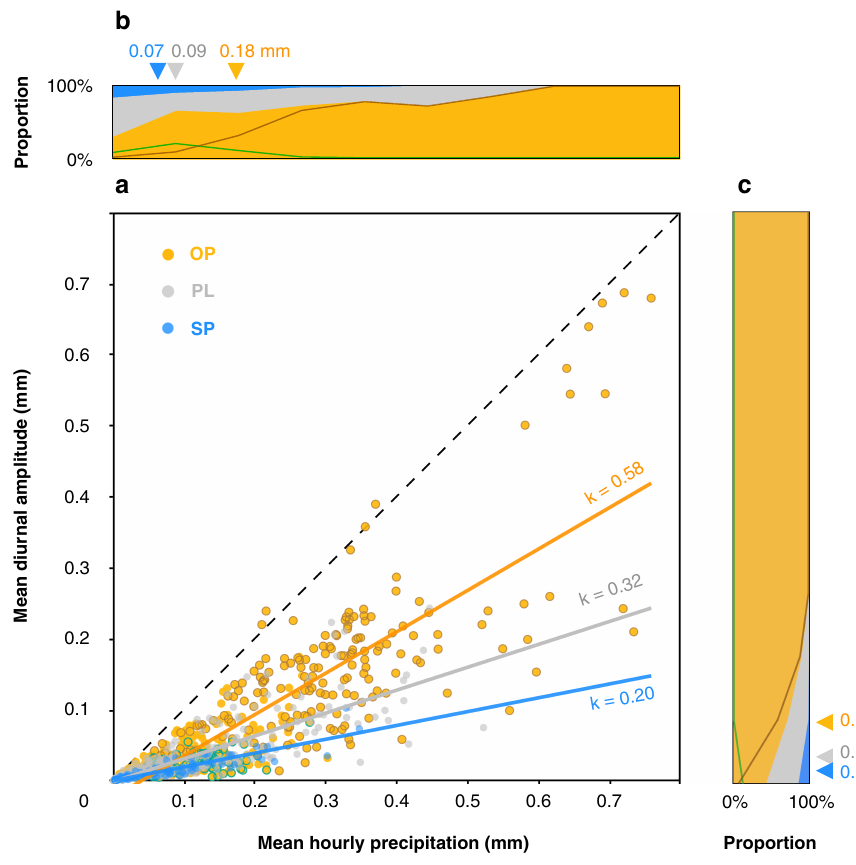
Fig. 2 | Precipitation and the diurnal amplitude per diurnal pattern. a Scatter diagram of the mean diurnal amplitude of rainfall versus mean hourly precipita- tion. OP, PL, and SP denote offshore propagation, phase-locked and shoreward propagation diurnal rainfall patterns, respectively. The orange dots with brown contours indicate OP samples with suf fi cient moisture ( q >11gkg − 1 ). The orange dotswith greencontoursindicate OP samplesathigherlatitudes (>30°).The weak or incoherent (WI) diurnal cycle is not shown. The mean hourly precipitation of eachsamplewascalculatedwithintherectangleenclosedbytheselectedcoastline and its offshore direction (perpendicular to the coastline) up to 250km. The diurnal amplitude was derived from the amplitude of the fi rst harmonic (diurnal cycle) in Fourier analysis. The black dashed line indicates that the mean hourly